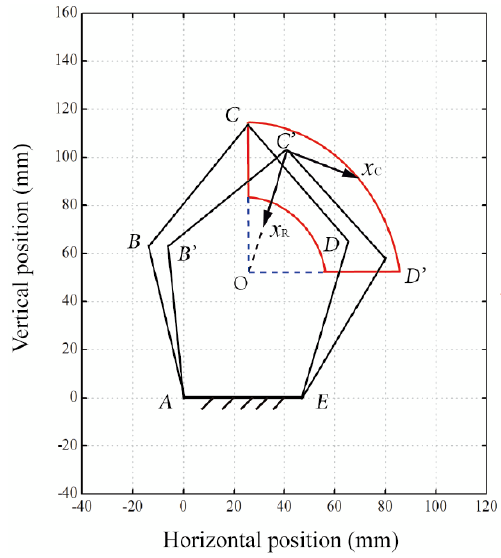
. R Figure 7. Workspace design.